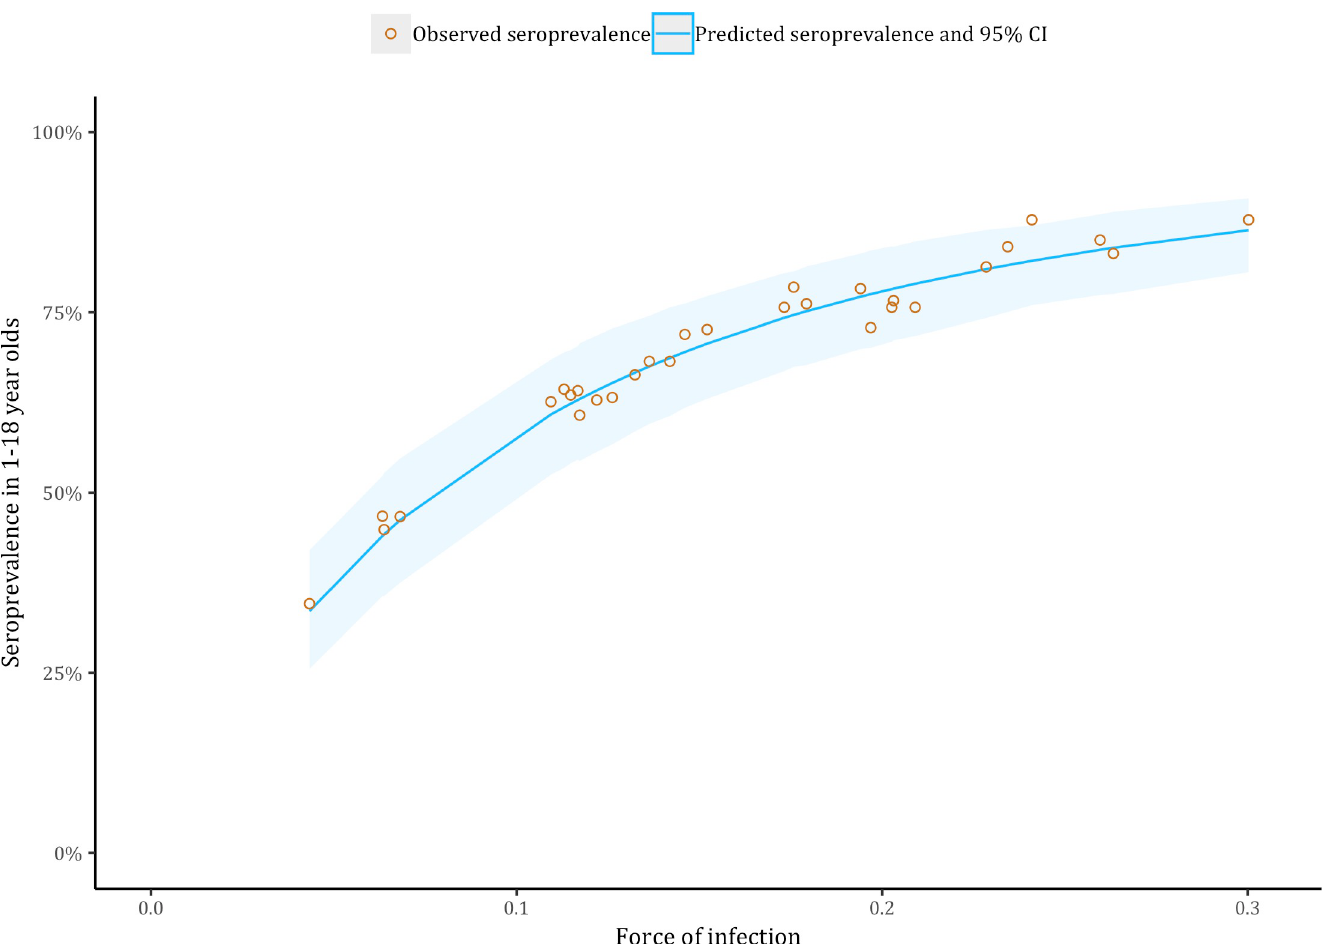
Fig 3. Observed (orange markers) and model-predicted (blue line) cluster-specific seroprevalence against estimated cluster-specific force of infection among children aged 1 to 18 years in Indonesia, 2014.